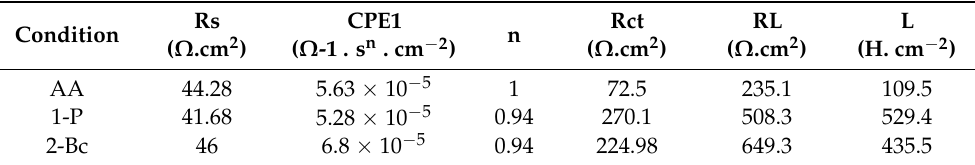
Figure 5. Equivalent circuit used to fit (EIS) data. Table 2. Electrical parameters obtained from fitting the electrochemical impedance spectroscopy (EIS) data of the ECAPed AZ31 alloys.